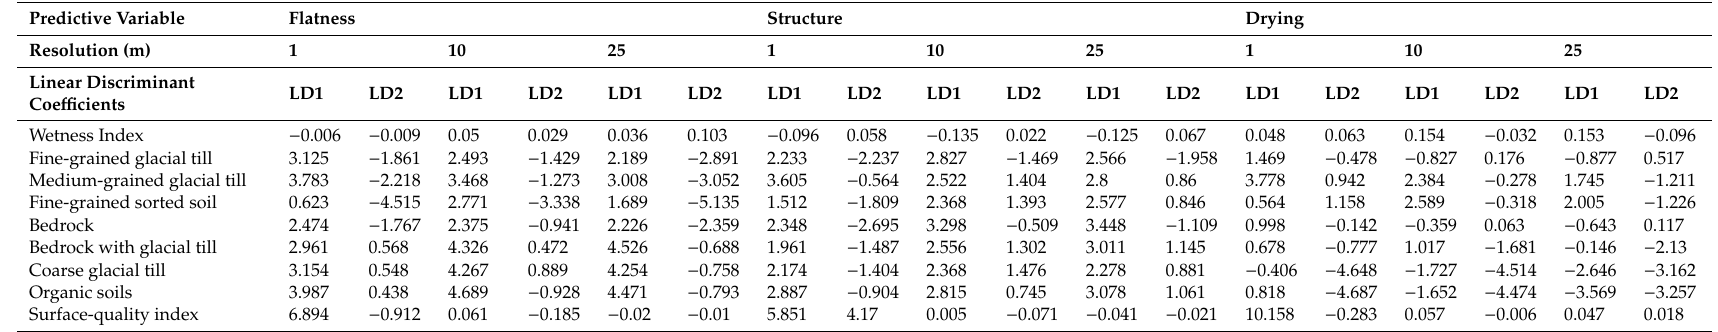
Table 5. Combinations of coe ffi cients for each linear discriminant based on the Linear Discriminant Analysis for a three-class classification. Three road-quality criteria (flatness, structure and drying) were predicted, using the wetness index, the surface quality index and di ff erent soil types. Each predictor was calculated at three resolutions: 1, 10 and 25 m. LD1: first linear discriminant. LD2: second linear discriminant.